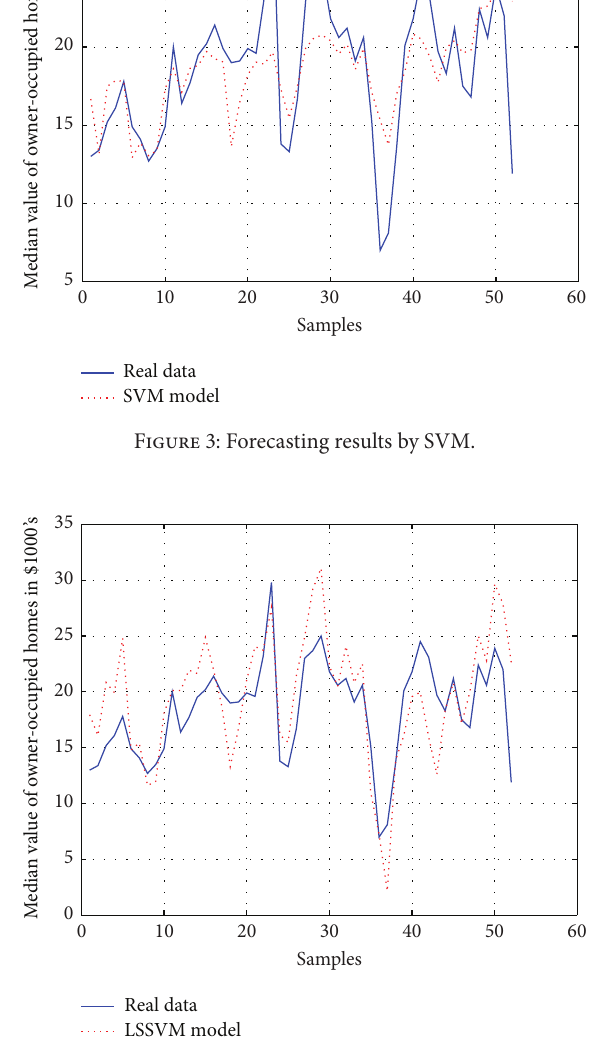
Figure 4: Forecasting results by